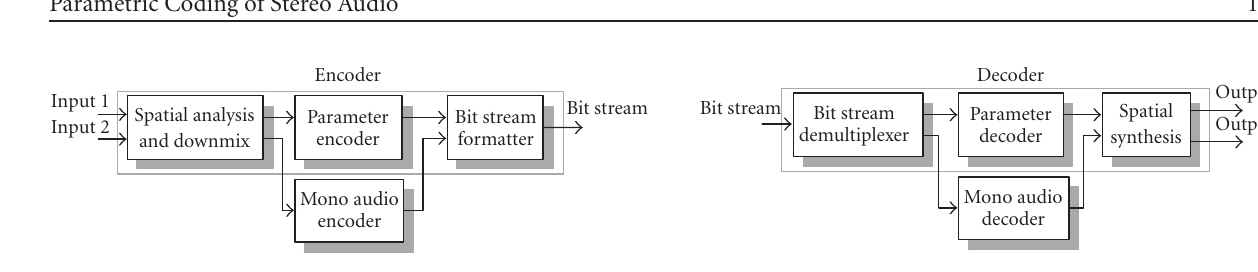
Figure 1: Structure of the parametric-stereo encoder. The two in- put signals are first processed by a parameter extraction and down- mix stage. The parameters are subsequently quantized and encoded, while the mono downmix can be encoded using an arbitrary mono audio coder. The mono bit stream and spatial parameters are sub- sequently combined into a single output bit stream.